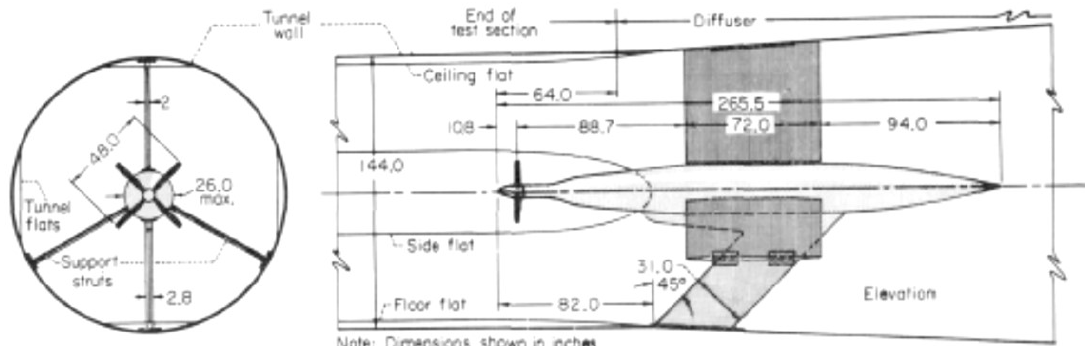
Figure 3. NASA Ames 1000 hp dynamometer schematic